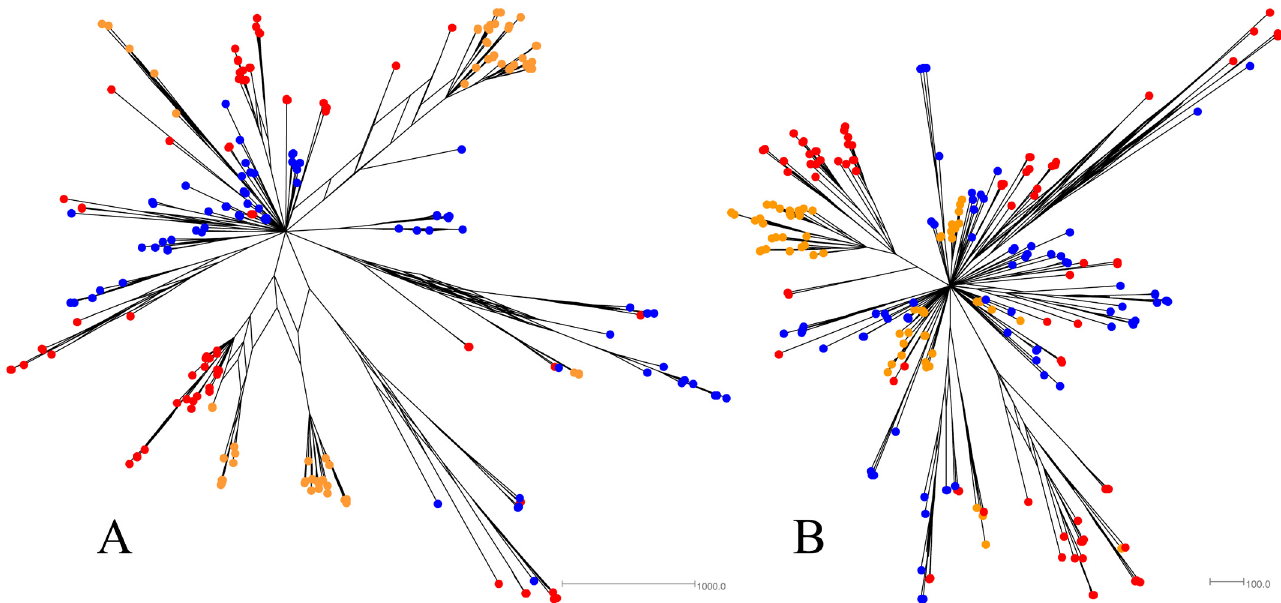
Fig 4. Consensus networks based on the posterior sets of trees for PI family 1. E2 (A) and NS5B (B) sequence alignments were evaluated independently. F1-G1 tips are orange, F1-G2 tips are blue, and F1-G3 tips are red.